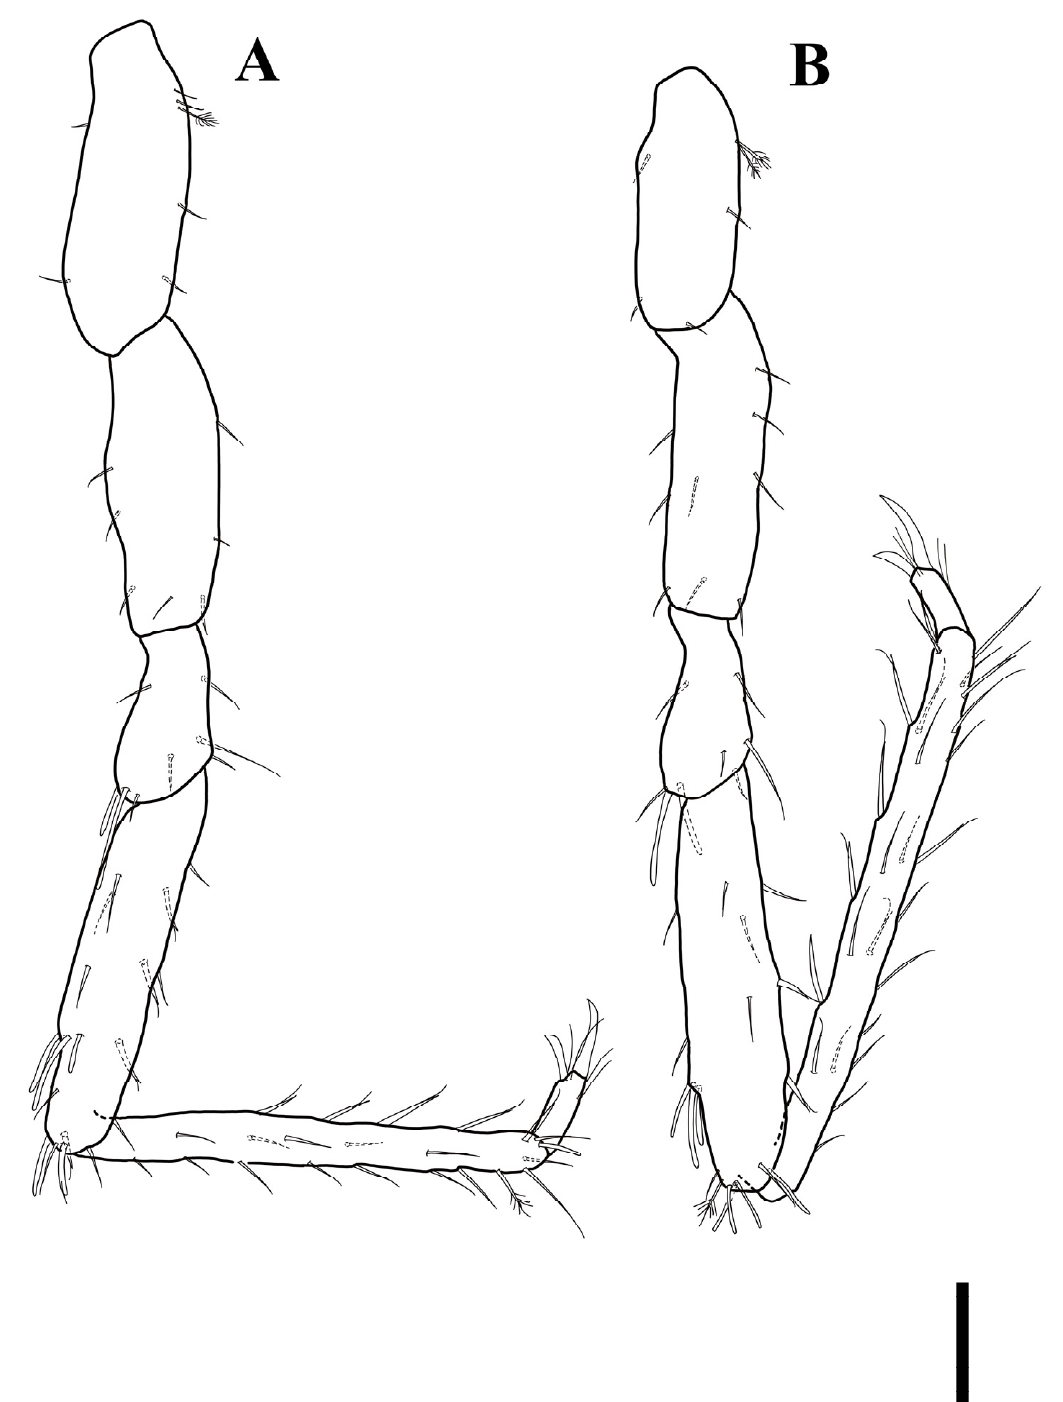
Figure 12. Uromunna jejuensis sp. n. holotype male: ( A ) pereopod 5; ( B ) pereopod 6. Scale bars = 100 μ m.